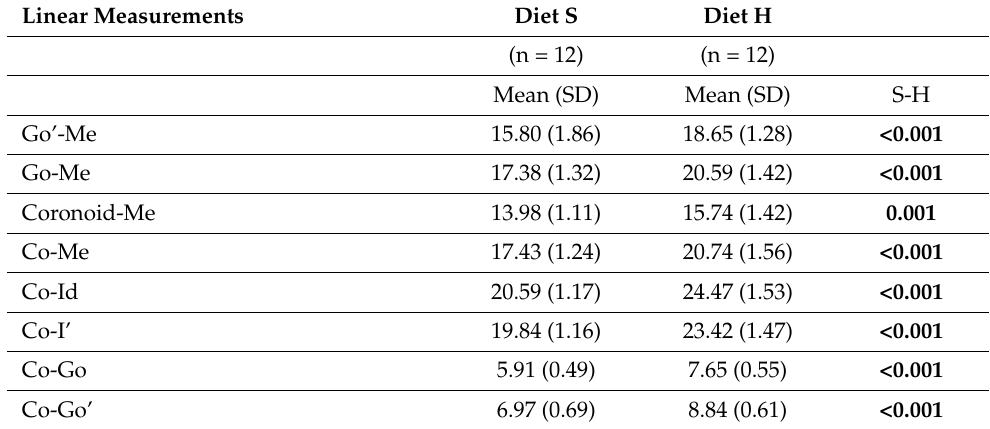
Table 5. Mean values, standard deviations and p values for all linear